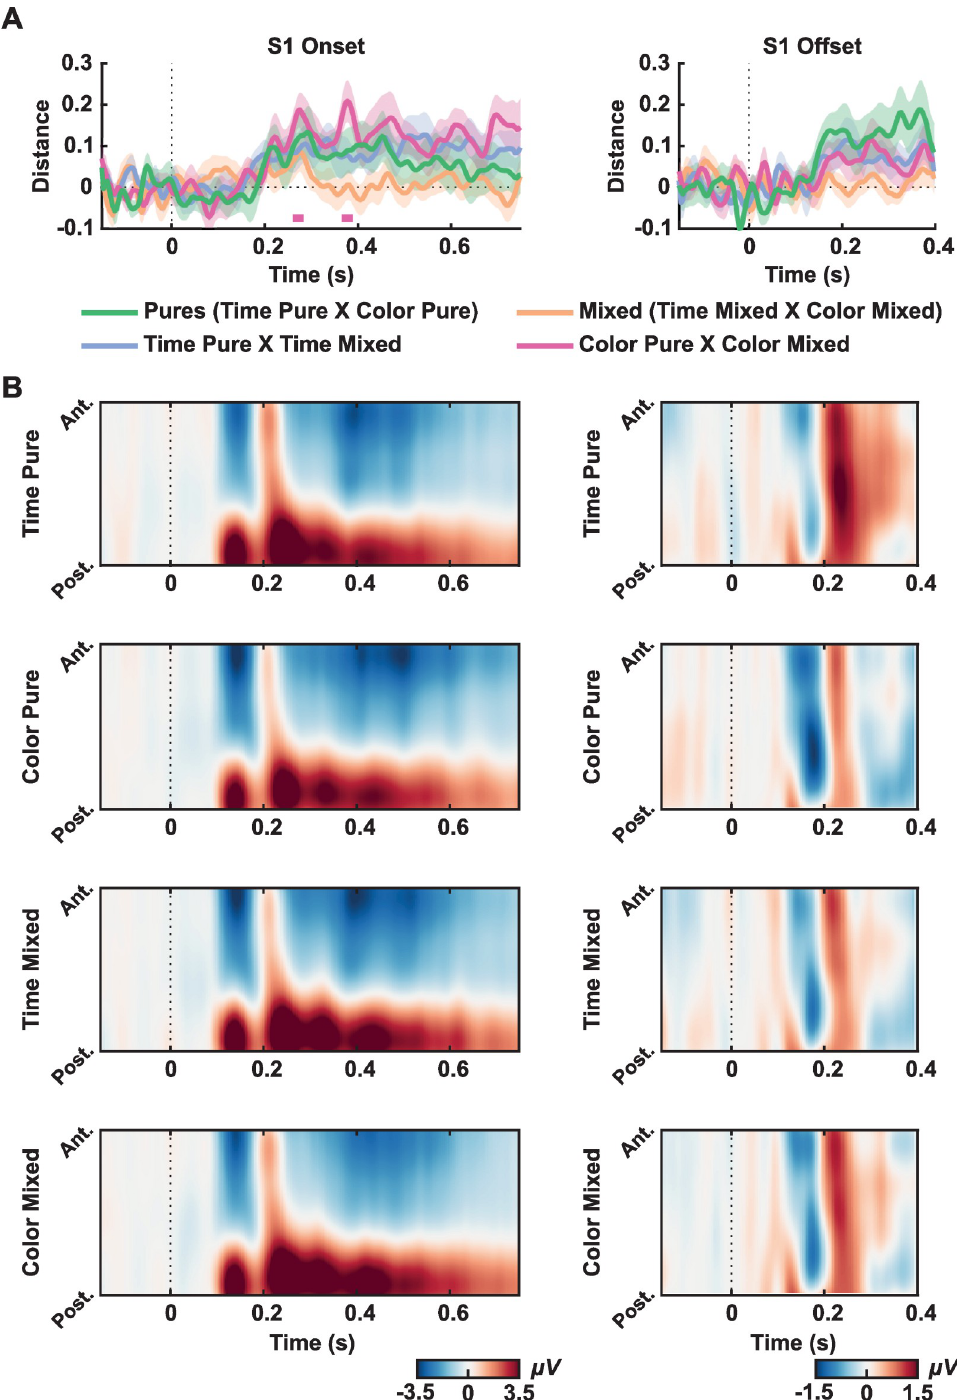
Fig 2. Exposure effects. (A) LDC distances between conditions for S1 onset (left) and S1 offset (right). The green curve indicates the mean distance between pure tasks (distance between Time Pure and Color Pure). The orange curve indicates the mean distance between mixed tasks (Time Mixed and Color Mixed). The purple curve indicates the mean distance between Time Pure condition and Time Mixed. The pink curve indicates the mean distance between Time Pure condition and Time Mixed. Shaded areas indicate the Standard Error of the Mean. Straight lines indicate significant windows for distances from the permutation test. (B) Spatial-temporal ERPs for each condition from S1 onset (right) and S1 offset (left). Graphs show the mean electrical potential between participants from a topographical organization